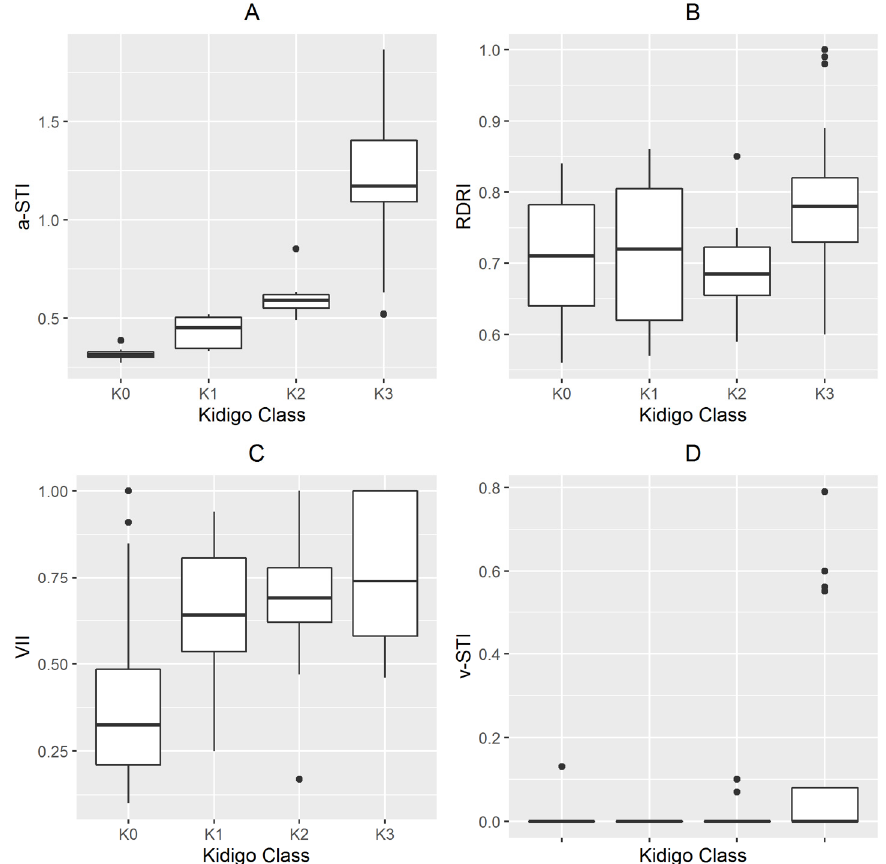
Figure 3. Doppler values assessed at ICU admission according to KDIGO stage at day 5. Panel ( A ) Arterial systolic time intervals (a-STI); Panel ( B ) renal Doppler resistive index (RDRI); Panel ( C ) renal venous impedence index (VII); Panel ( D ) venous time intervals (v-STI); Kidney Disease Improving Global Outcomes score